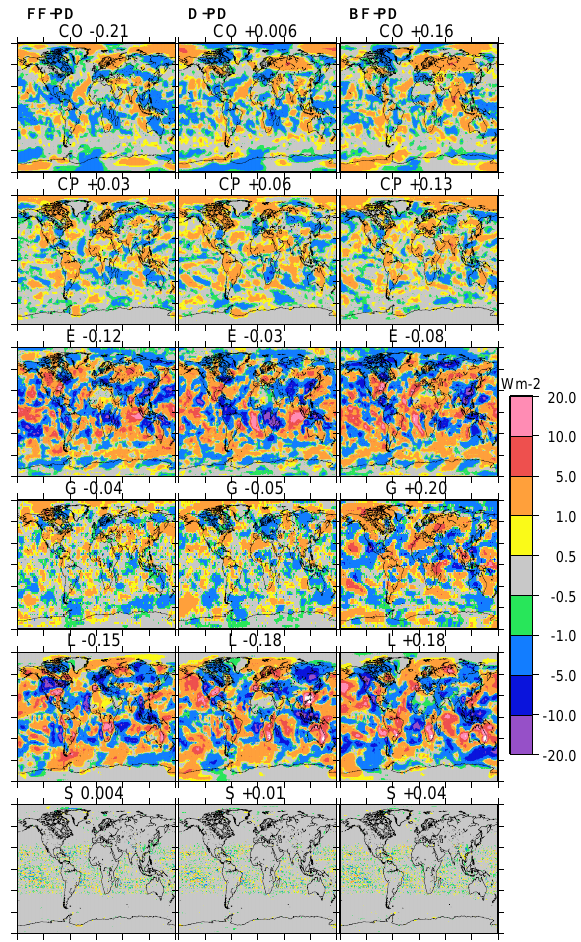
Fig. 6. Annual mean radiative flux change at top-of-atmosphere for cloudy-sky between the fossil fuel (left), diesel (middle) and biofuel (right) reduction experiments and the full simulation. L and E models use short-wave flux only. Each row is one